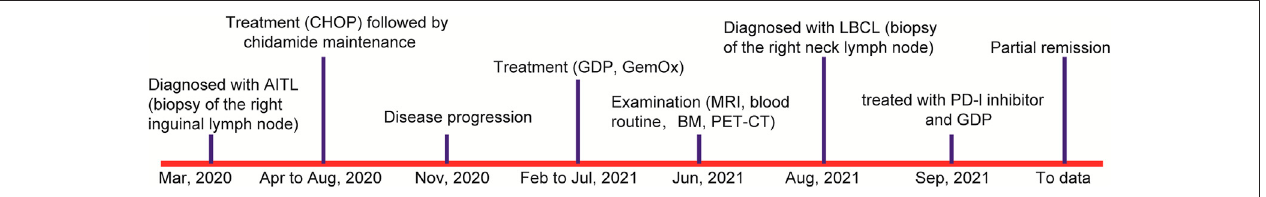
FIGURE 1 | Important events of the patient according to the